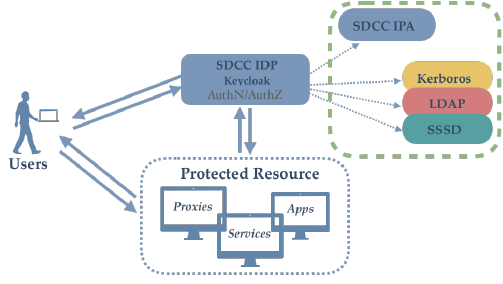
Figure 1. Single Sign On for SDCC users for local web